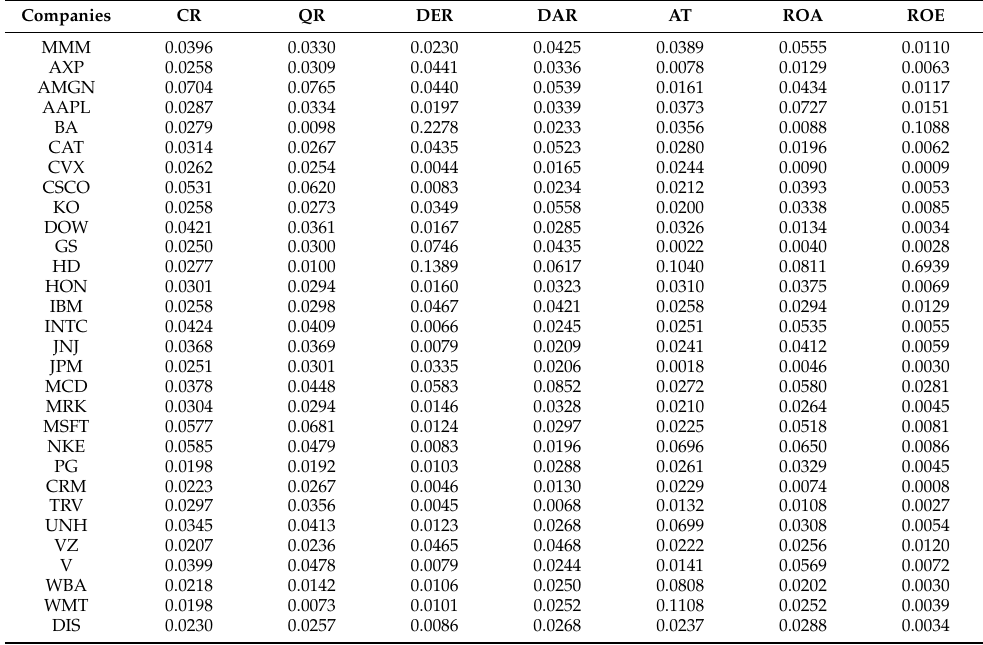
Table 4. The normalized decision matrix for the companies with respect to all financial ratios.